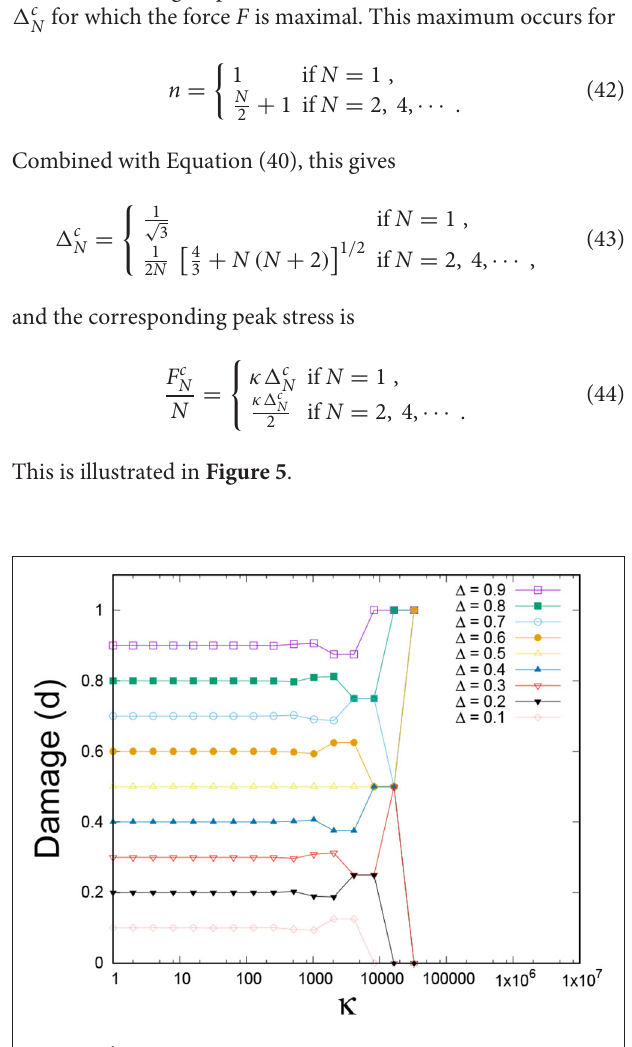
FIGURE 2 | Evolution of threshold distribution for M 10 4 fiber bundles, each FIGURE 3 | Flow in parameter space under the renormalization group = containing N 2 12 fibers when repeating the order space renormalization transformation (37) projected onto the ( κ , d ) plane. The initial number of fibers = group transformation. The initial threshold distribution was non-uniform (linearly was N 2 15 , and the data are averaged over 10 6 samples. The = increasing) on the unit interval. We have added a constant factor to p ( t ) for renormalization group is iterated 15 times so that the last bundle contains one each iteration of the renormalization group in order to separate them. fiber. The threshold distribution was uniform on the unit